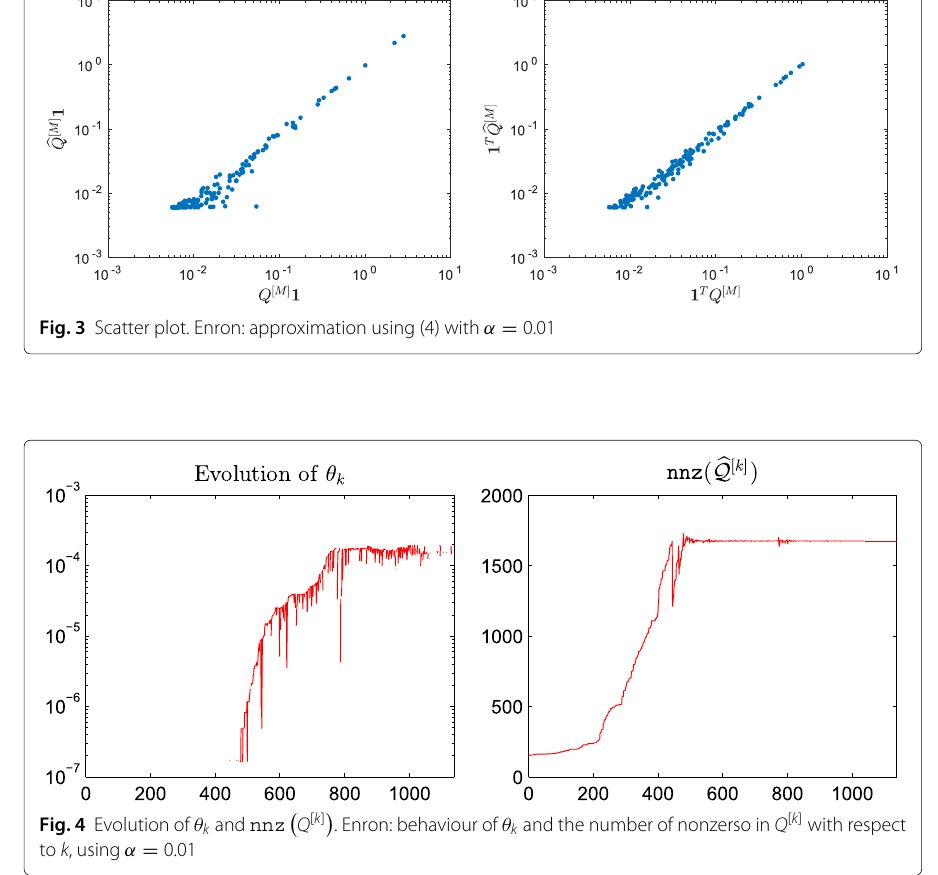
Fig. 4 Evolution of θ k and nnz to k , using α = 0.01